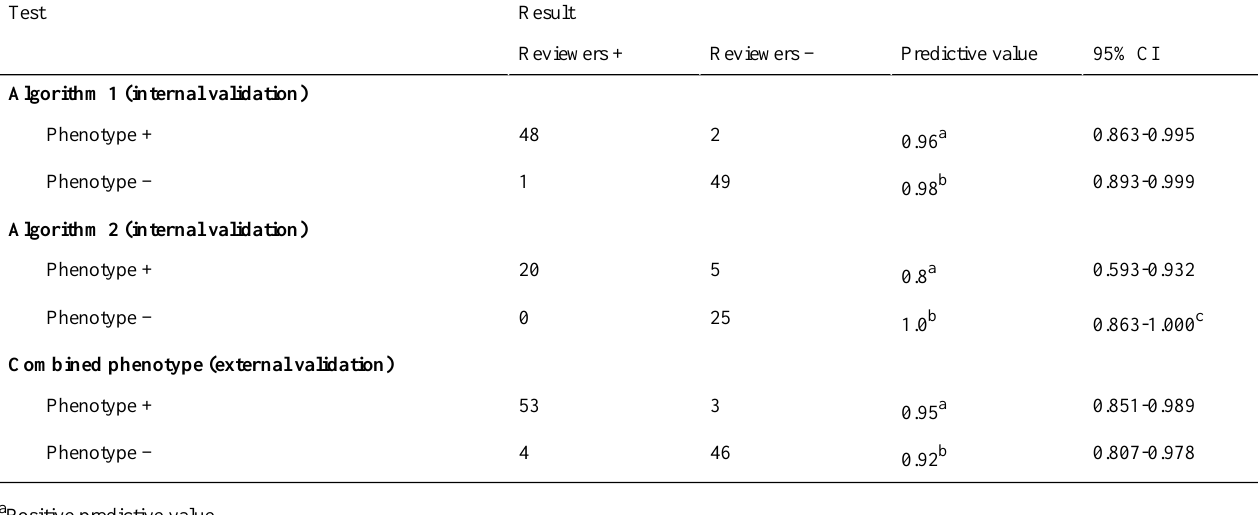
Table 3. Confusion matrices for validation phases (disease present: reference standard). ResultTest